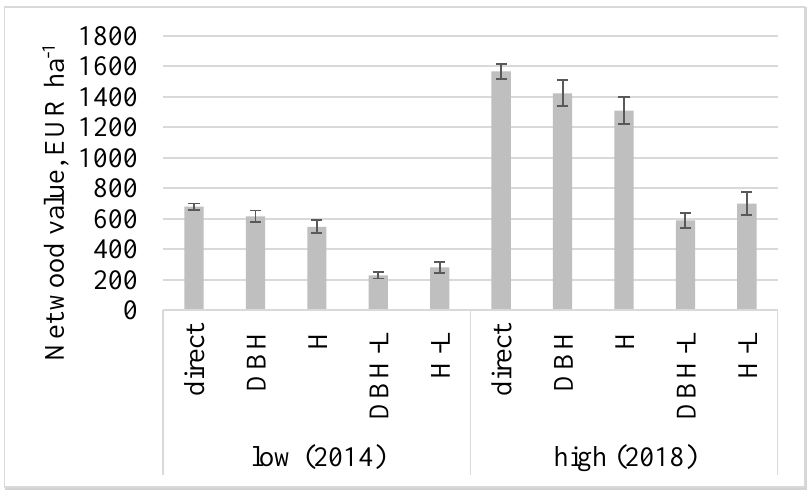
Figure 1. Net wood value of the thinning at the age of 14 years, based on low or high timber prices and selection of 10% best or worst (-L) families either directly (by value) or indirectly (by DBH or by height at the age of 10 years). Table 3. The economic indicators of the selected trees of the silver birch trial at the first thinning at the age of 14